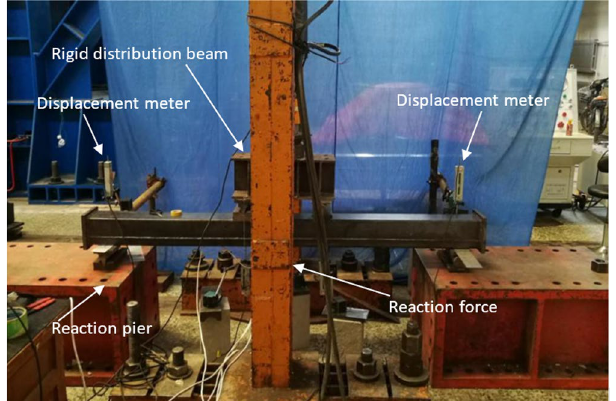
Figure 1. Test set-up.